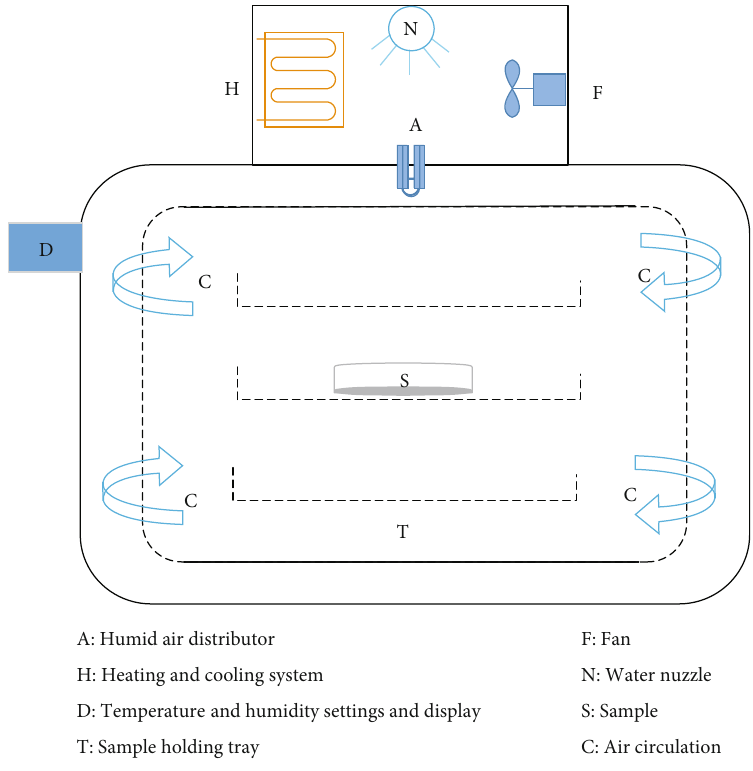
Figure 1: Schematic diagram of the dynamic temperature-humidity (DTH)